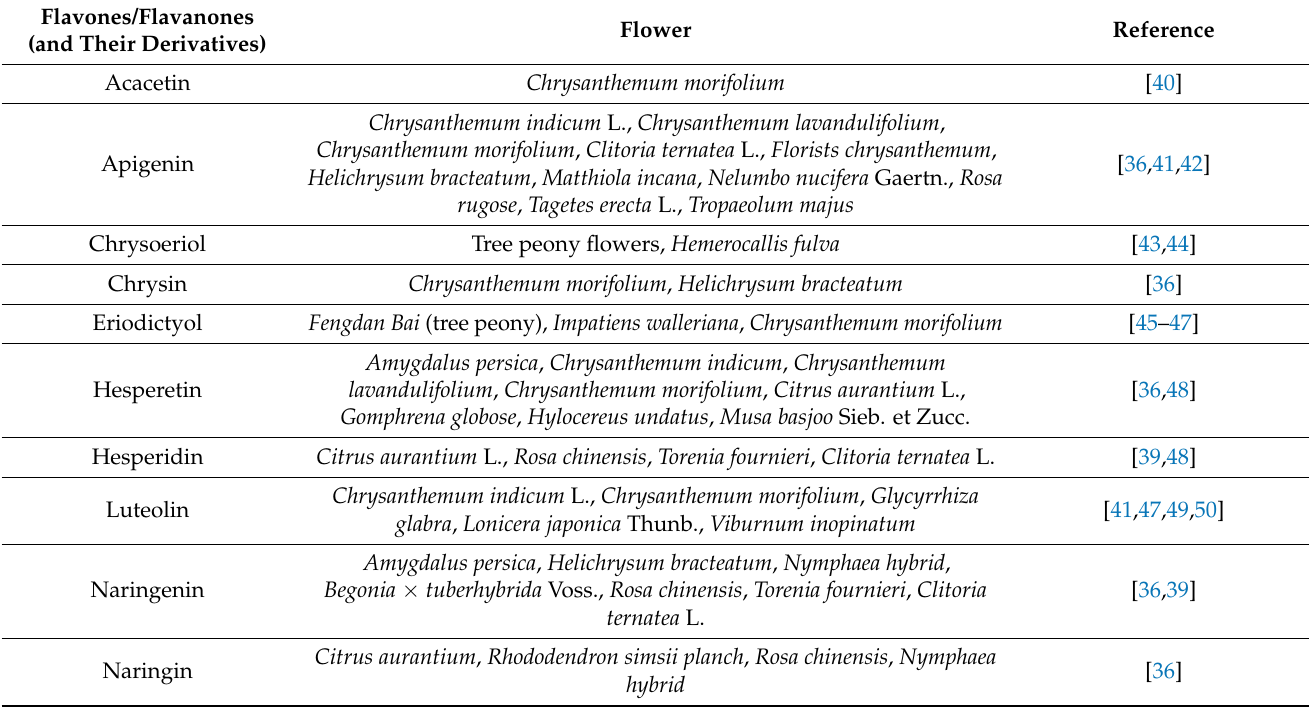
Table 7. Major flavones and flavanones detected in several edible